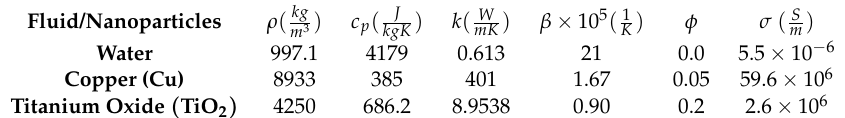
Table 1. Thermophysical properties of nanoparticles and water [45].